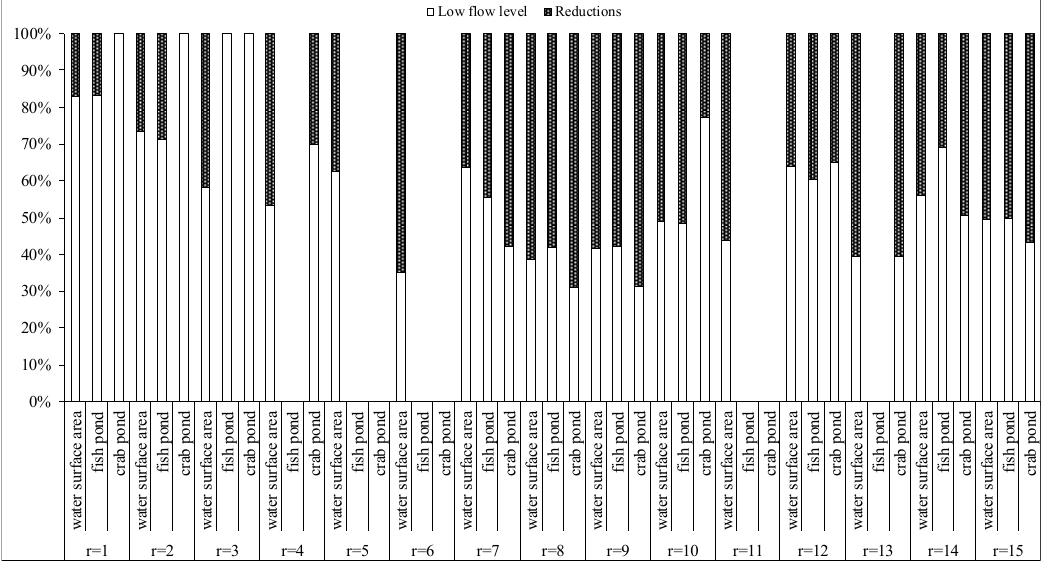
Figure 6. Reduction in initial planned restored water surface area in western Jilin Province under the scenario of a low flow level. Water 2019 , 11 , x FOR PEER REVIEW